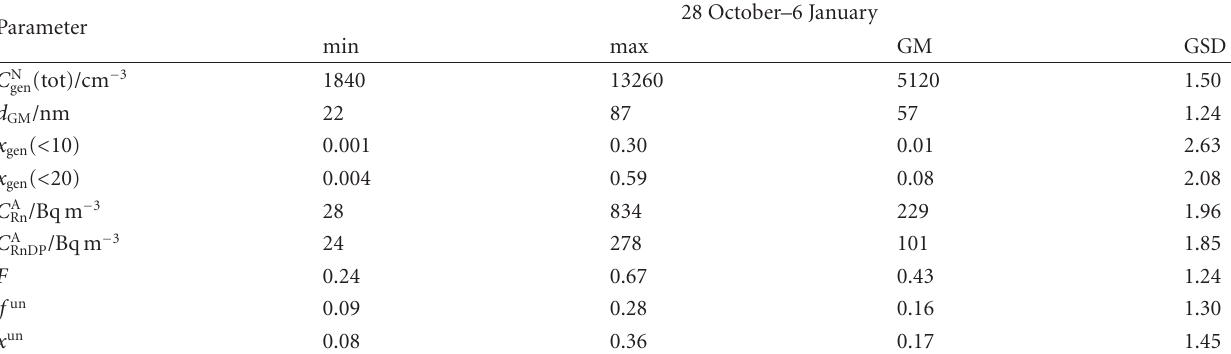
Table 2: Minimum and maximum values, geometric means, and geometric standard deviations for the total number concentration of (tot)), geometric mean of number size distribution of general aerosol ( d GM ), number fractions of particles smaller than general aerosol ( C N gen 10nm ( x gen ( < 10)) and smaller than 20nm ( x gen ( < 20)), radon activity concentration ( C A ), equilibrium equivalent concentration of radon Rn ), equilibrium factor between radon and radon short-lived decay products ( F ), activity fraction of the short-lived decay products ( C A RnDP unattached radon short-lived decay products ( f un ), and number fraction of the unattached radon short-lived decay products ( x un ), for the entire period of measurements indoors (28–31 October, 21-22 November, and 5-6 January), only when the door and window were closed and without any human